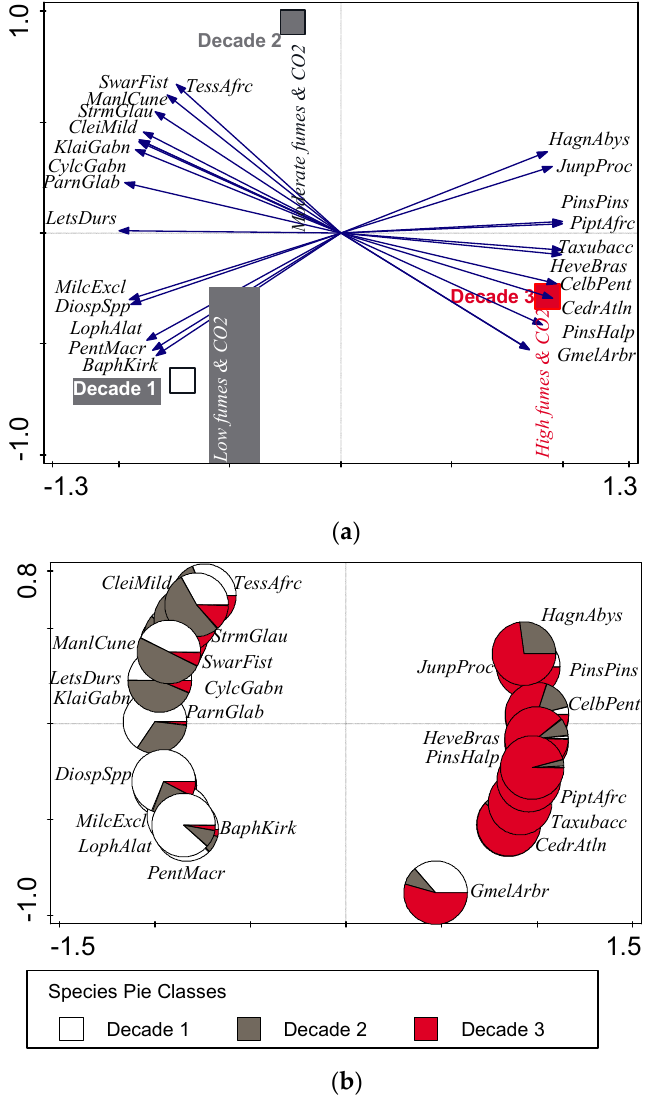
Figure 6. Biplot from the multivariate analysis of ordination showing the study decades and their associated common tree species for the wood charcoal production in the four countries (Nigeria, Ghana, Senegal and Ethiopia). ( a ) Indicated the distribution of species and their pollution emission (fumes and CO 2 ) status for each decade, ( b ) showed the proportion of species for each decade. Description of the plant species abbreviations is shown in Table 4.